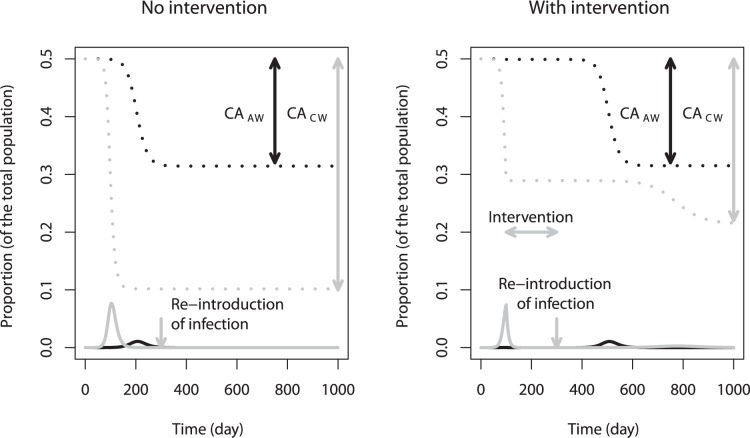
Time series of a simulated epidemic in a population in which there is no transmission between adults (black) and children (grey), in the absence (left) or presence (right) of an intervention.Broken line: susceptible; solid line: infected. CAAW: Cumulative attack rate (adults, with whole population as the denominator); CACW: Cumulative attack rate (children, with whole population as the denominator). Infection was re-introduced into the population on day 300. The intervention (fAA = fAC = fCA = fCC = 1) started on day 100 (when the children’s epidemic is at its peak) and lasted until the first outbreak was over. βAC = βCA = 0; R0A = 1.25; R0C = 2. 50% adults; 50% children. All other parameters and initial conditions are listed in Tables 1 and 2.